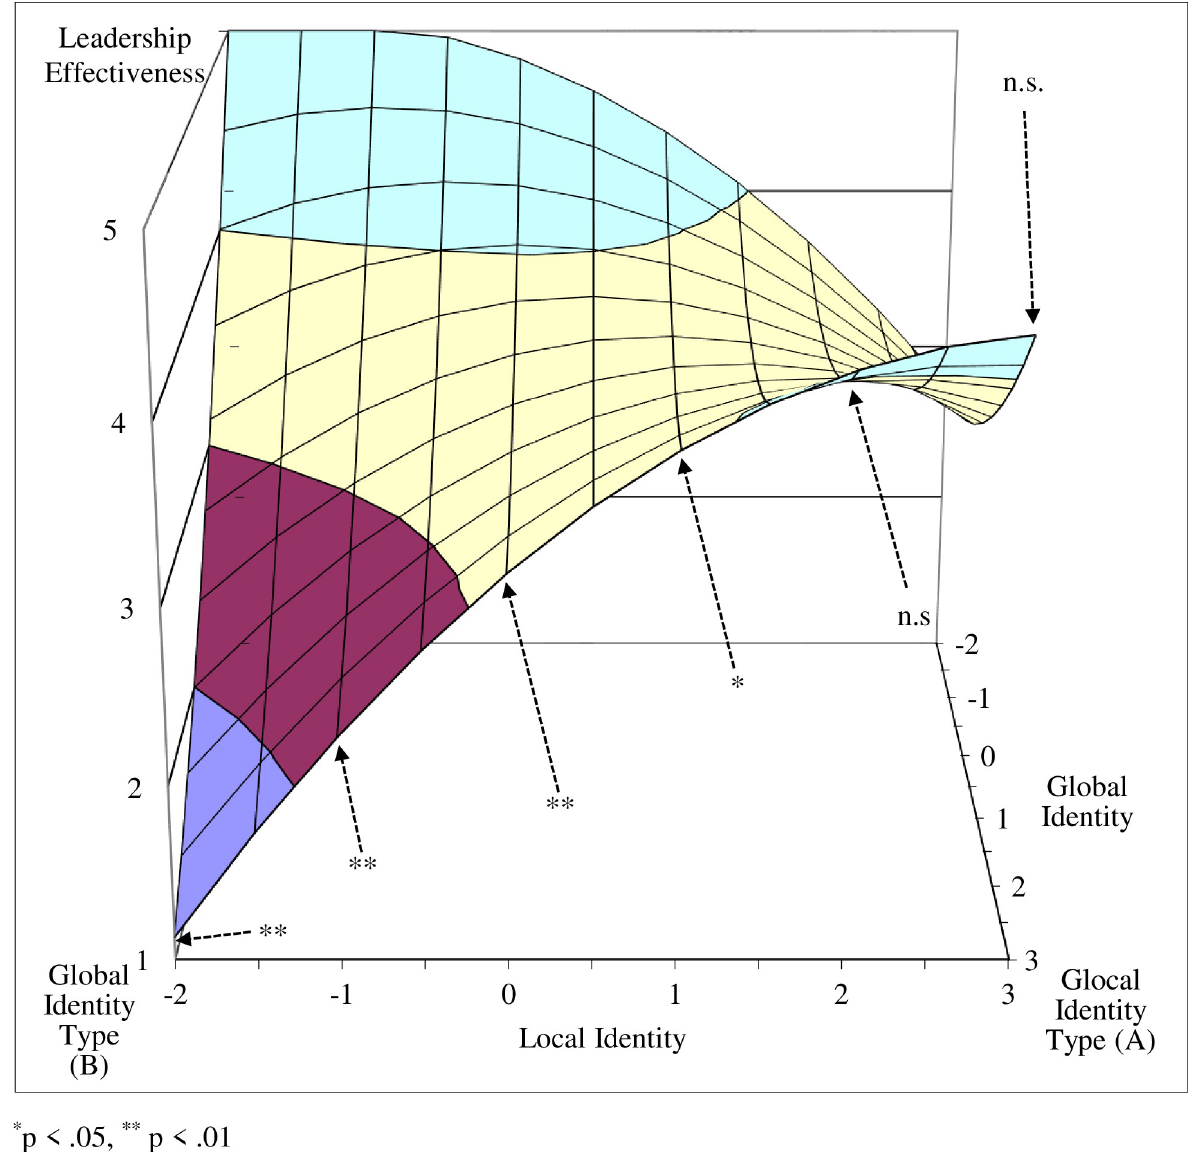
Fig 8. Tangent slope significance along the global–glocal line as predictor of leadership